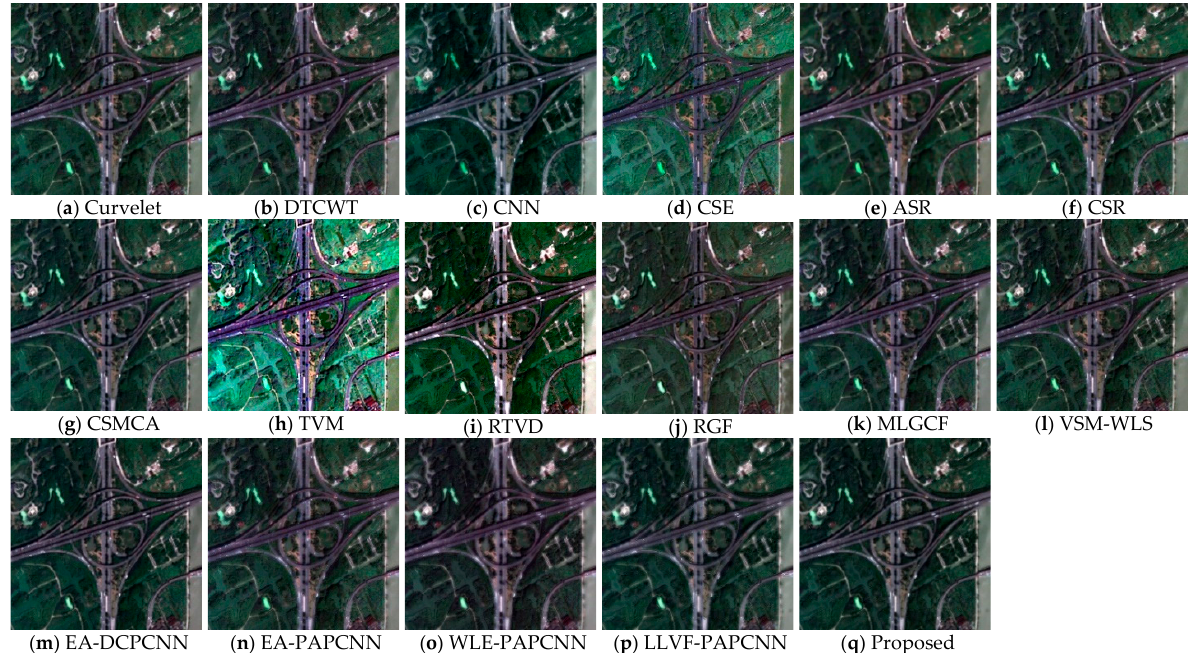
Figure 13. Fusion effect of Pleiades image.